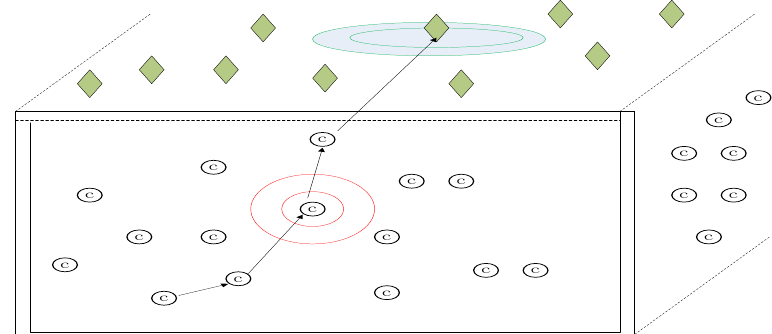
Figure 14. The architecture of underwater acoustic sensor networks. The sink node in the green circle and the sensor node in the red circle are the examples with special emphasis.